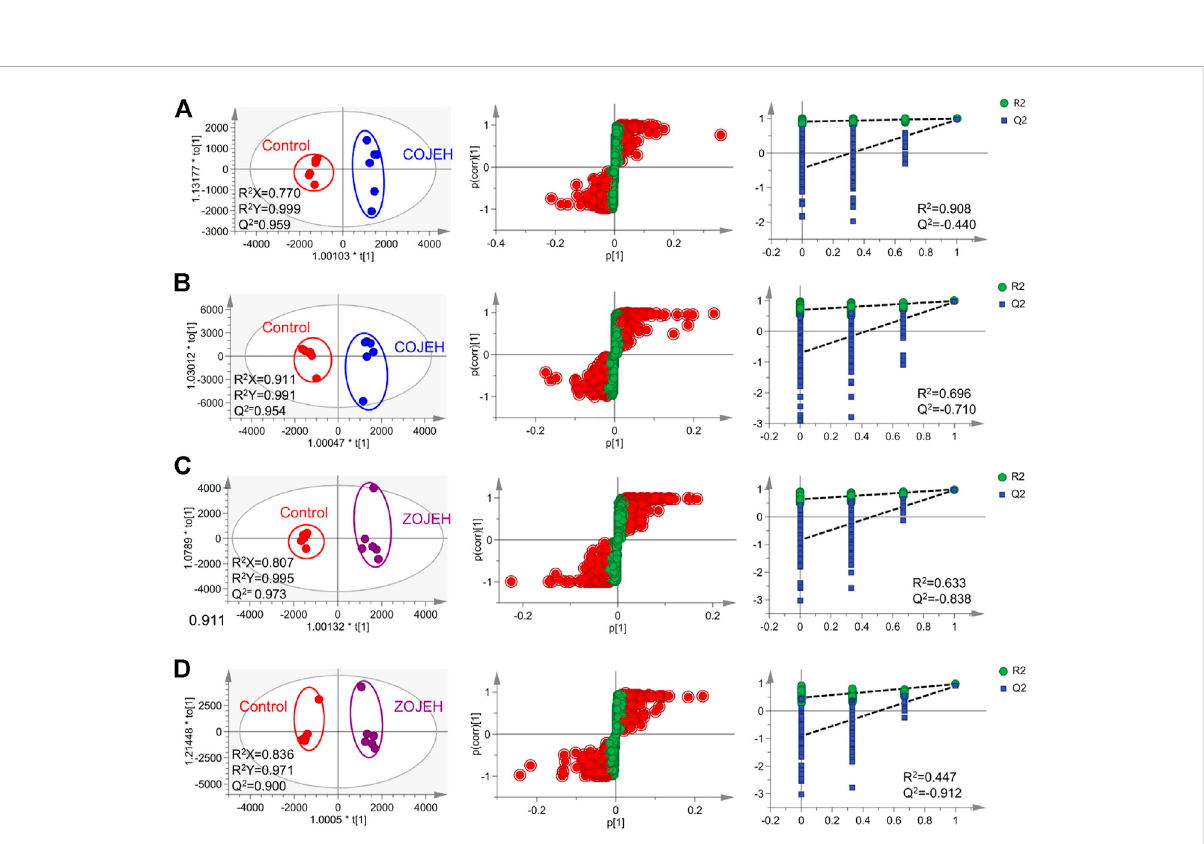
FIGURE 5 OPLS-DA score plot (left), S-plot (middle) and permutations test (right) based on the UHPLC/Q-TOF-MS spectra of NCI-H1299 cell samples in controland( A,B )COJEH-or( C,D )ZOJEH-treatedgroupdetectedin( A,C )positiveionmodeand( B,D )negativeionmode.Potentialbiomarkerswith VIP > 1.0 were marked as